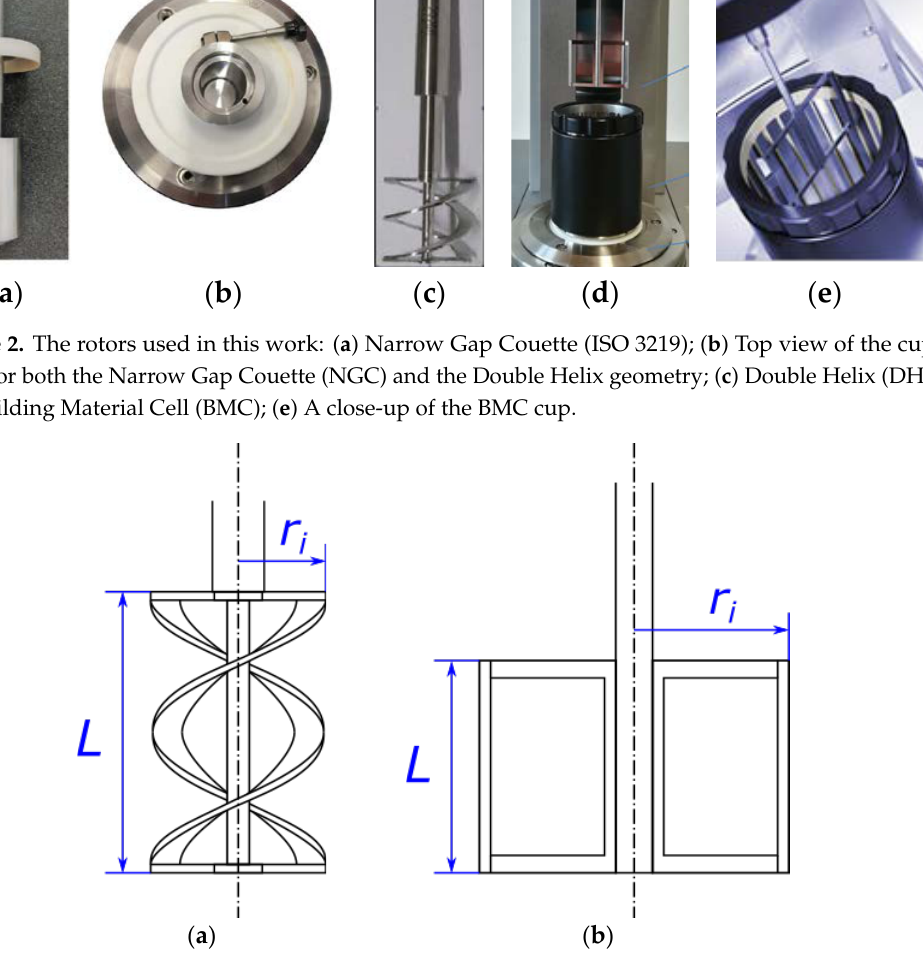
Figure 3. Drawing of the two complex rotors and their main dimensions: ( a ) Double Helix (DH); ( b ) Building Material Cell (BMC).